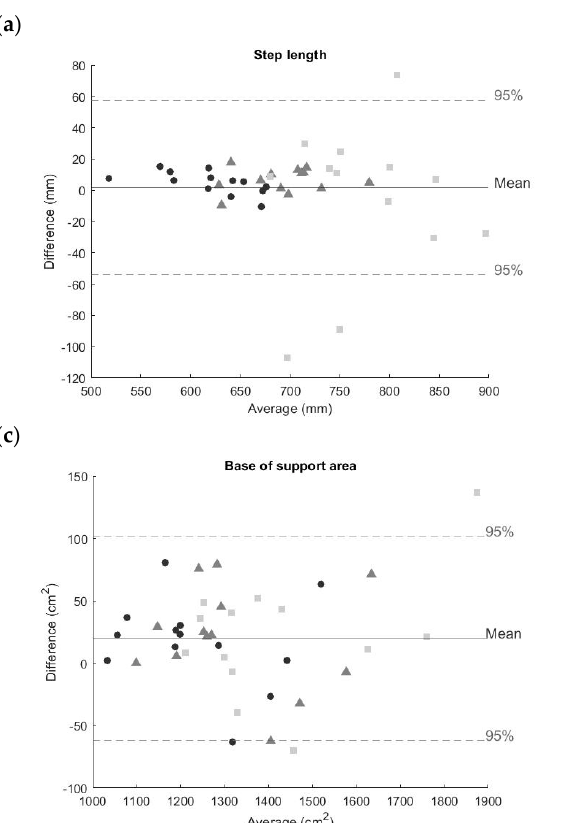
1246 ± 148 1238 ± 160 1434 ± 218 ME ± SD (cm 2 )